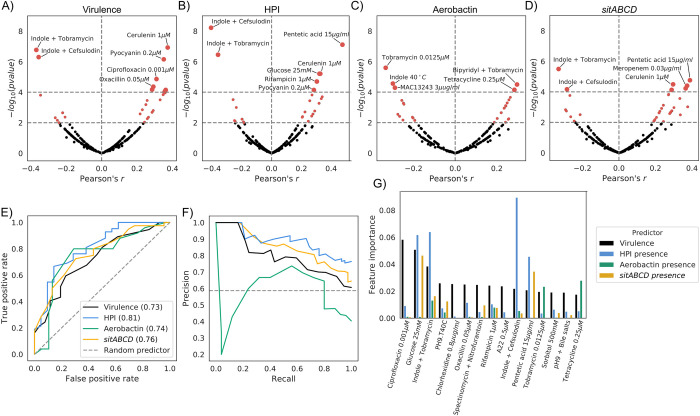
Growth profiles can predict virulence and presence of virulence factors.A-D) Volcano plots for the correlation between the strains’ growth profiles and: A) virulence levels, B) presence of the HPI, C) presence of aerobactin, and D) presence of sitABCD. E-F) Use of the strains’ growth profiles to build a predictor of virulence levels and presence of the three iron uptake systems. E) Receiver operating characteristic (ROC) curves and F) Precision-Recall curve for the four tested predictors. G) Feature importance for the predictors, showing the top 15 conditions contributing to the virulence level predictor.